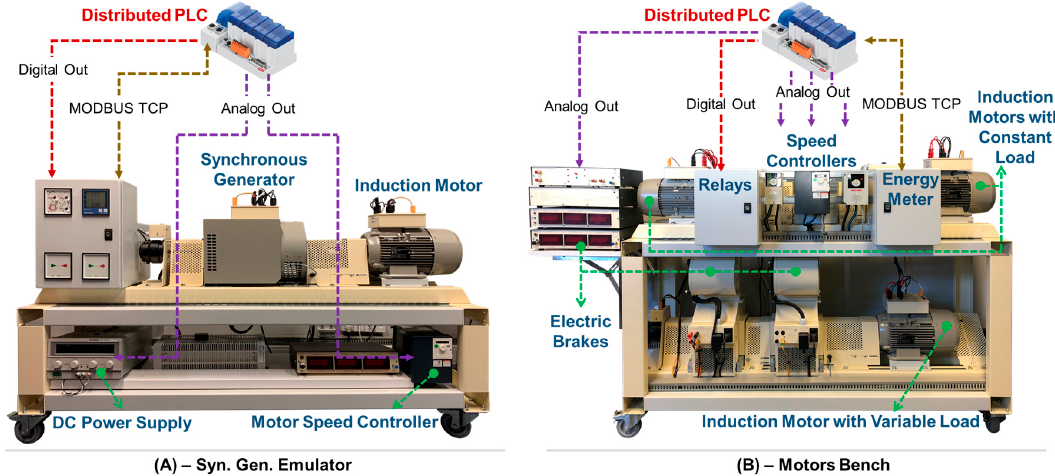
Figure 2. Automation approaches implemented in laboratory synchronous generator and electric motor emulators for experimenting case studies.